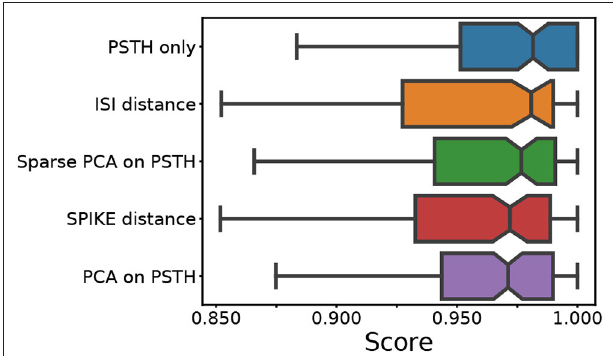
FIGURE 2 | Median score across all conditions. For each of the five feature sets, four external clustering quality scores (adjusted Rand index, adjusted mutual information score, V-measure, and the Fowlkes-Mallows score) were computed for each dataset. The median of the four scores is calculated for each dataset. Finally, the medians for the various datasets (140) are presented in the form of a box plot, one for each method. A higher score implies a better clustering result. Each colored box plot shows the median and interquartile range (IQR). The error bars extend 0.8 times past the IQR in each direction. The methods are ordered from the highest median value (of median scores) to the lowest, from top to